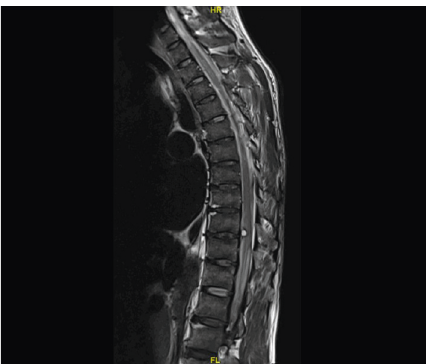
Figure 1: T2MRI of the entire spine showing an abnormal signal in the spinal canal and a hyperintensity of 5mm in the anterior spinal canal likely intradural and extramedullary at the lower T9 level.